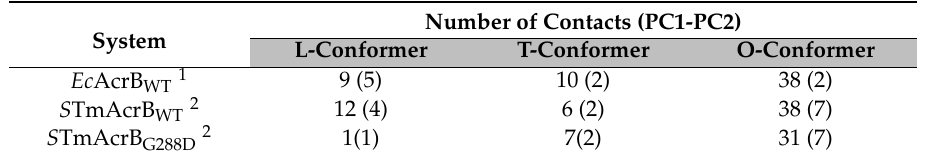
Figure 6. Close-up of the residue 288 and surrounding residues of the HP trap in S Tm AcrB WT and S Tm AcrB G288D . Waters belonging to the first and second hydration shell of residue 288 (distance threshold: 5 Å, see Materials and Methods) are also shown, and hydrogen bonds involving residue 288 are represented as dashed lines. This image has been created using two representative frames of MD trajectories. Table 5. Number of contacts between the subdomains PC1 and PC2 in the three conformers of AcrB. Two residues have been considered in contact if the distance between their C α s is below 10 Å (see Materials and